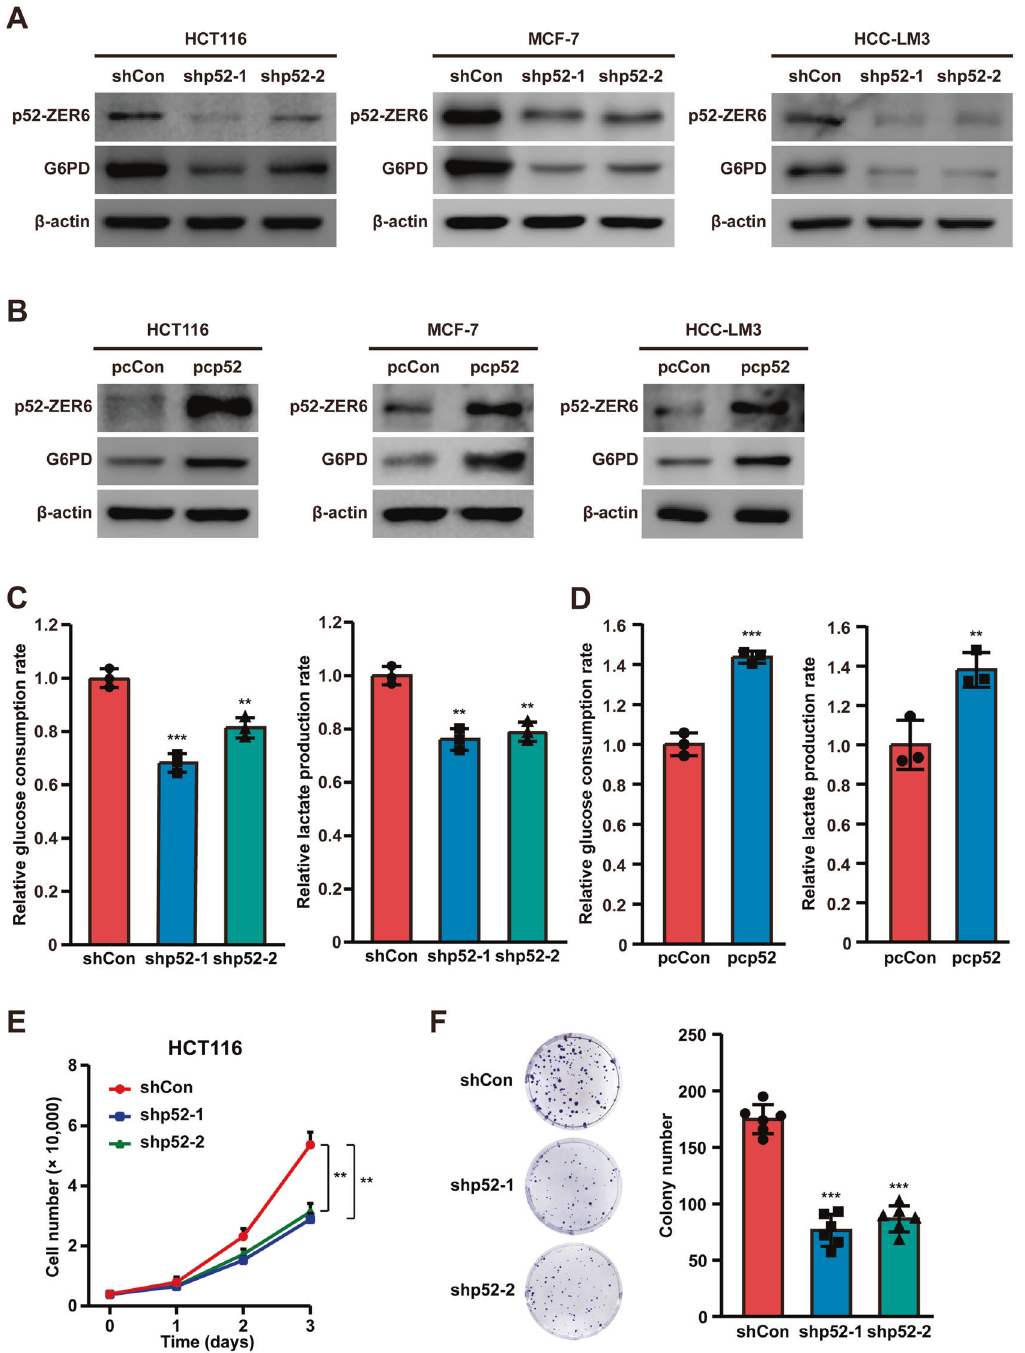
Fig. 2 p52-ZER6 positively regulates G6PD expression and enhances tumor cells glucose metabolism. A G6PD protein expression levels in p52 - ZER6 -silenced HCT116, MCF-7, and HCC-LM3 cells, as determined using western blotting. B G6PD protein expression levels in p52 - ZER6 - overexpressed HCT116, MCF-7, and HCC-LM3 cells, as determined using western blotting. C , D Glucose consumption (left) and lactate production (right) levels in p52-ZER6 -silenced ( C ) and p52-ZER6 -overexpressed ( D ) HCT116 cells. E Viability of p52-ZER6 -silenced HCT116 cells at indicated time points. F Colony formation potential of p52-ZER6 -silenced HCT116 cells. Representative images (left) and quanti fi cation results (right; n = 6) are shown. Cells transfected with shCon or pcCon were used as controls. β -actin was used as western blotting loading control. Total protein was used for normalizing the levels of glucose consumption and lactate production. Quanti fi cation data are expressed as mean ± SD ( n = 3, unless otherwise indicated). shp52: shRNA expression vector targeting p52-ZER6 ; pcCon: pcEF9-Puro; pcp52: p52-ZER6 overexpression vector; ** P < 0.01; *** P < + 622 region; G6PD-luc-2, which contained the − 1657 to + 622 G6PD promoter using a eukaryotic promoter database region; G6PD-luc-3, which contained the − 1158 to + 622 region; (www.epd.isb-sib.ch/) [11]. Accordingly, we constructed four and G6PD-luc-4, which contained the + 70 to + 622 region (Fig. luciferase reporter assay vectors carrying different regions of 5A). Luciferase assays revealed that p52-ZER6 silencing the G6PD promoter: G6PD-luc-1, which contained the -2,289 to